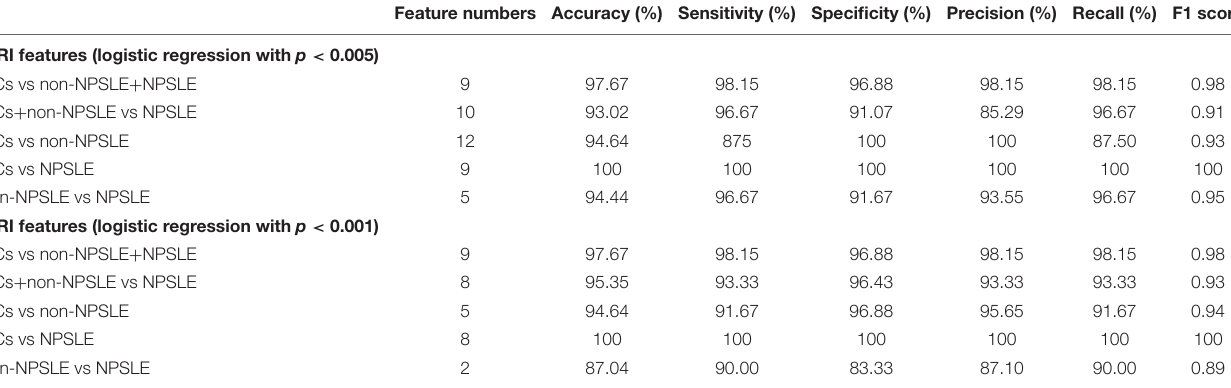
MRI features (logistic regression with p <